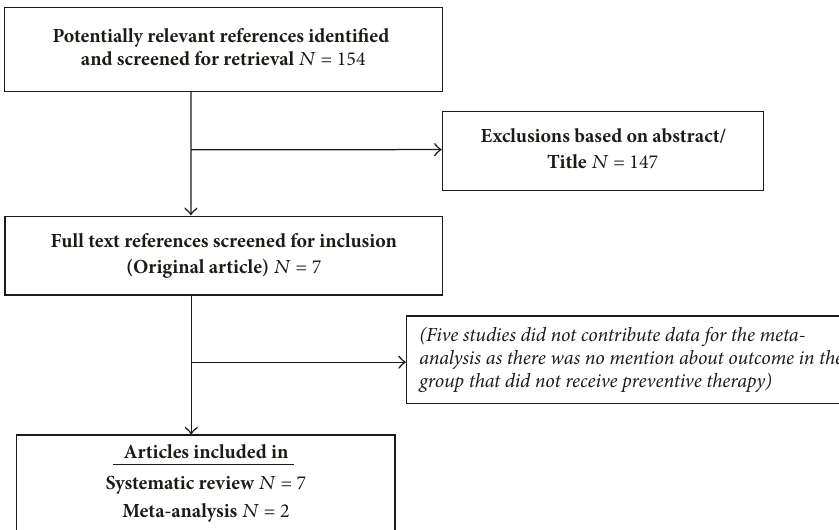
Figure 1: Search result of the